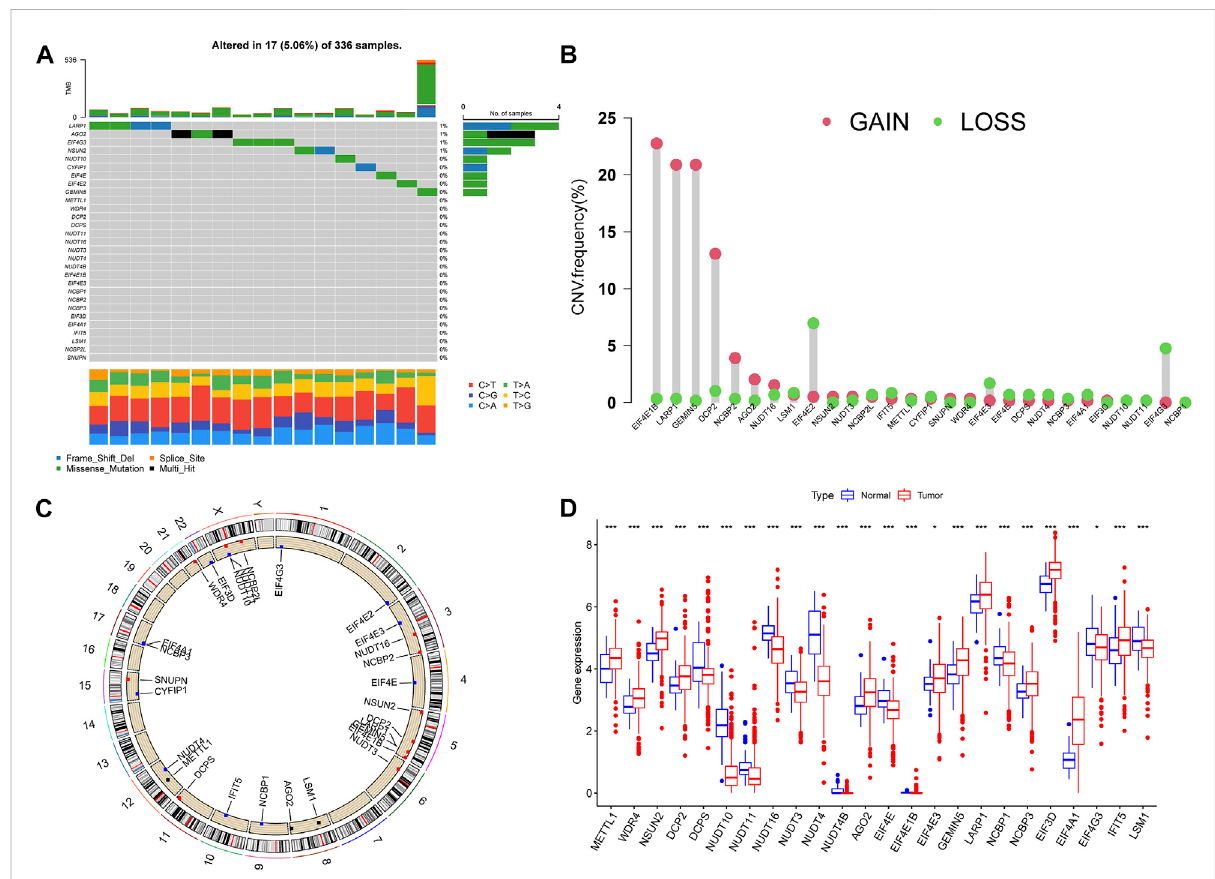
Variation of m7G-related genes in ccRCC. (A) Genetic alteration on a query of m7G-related genes. (B) The frequency of CNV in m7G-related genes. (C) The locationoftheCNValteration ofthem7G-related geneschangeson 23chromosomes. (D) Geneexpression ofm7G-related genesin ccRCC and normal samples. * p < 0.05, ** p < 0.01, *** p < 0.001; ccRCC, clear cell renal cell